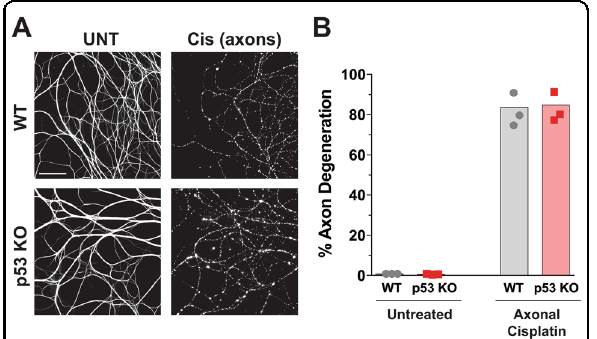
Fig. 4 p53-de fi ciency failed to protect axons from cisplatin- induced mtDNA damage. A Neurons were isolated from wildtype and p53-de fi cient mice and treated with cisplatin exposed onto to the axon compartment (Axonal Cisplatin; 20 μ M) for 120 h and stained for tubulin ( n = 3). The scale bar depicts 100 μ m. B Quanti fi cation of the axon degeneration of the experiments in A ( n = 3), individual data points and mean are depicted.